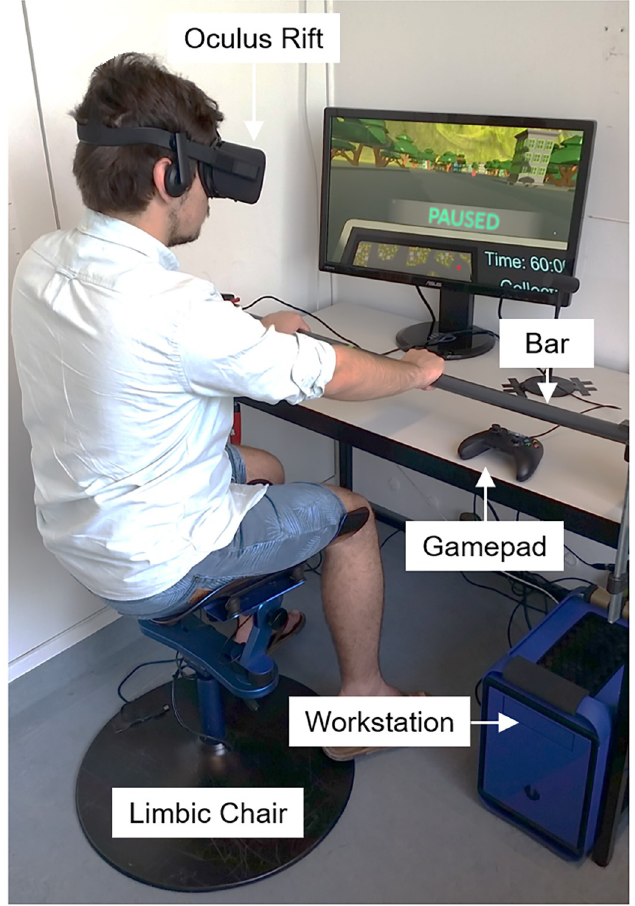
Fig 2. Our VR system is composed of an Oculus Rift, a Limbic Chair, a gamepad, a workstation, and a horizontal bar fixed to the workbench. The user can move his left and right legs independently while balancing on the chair.